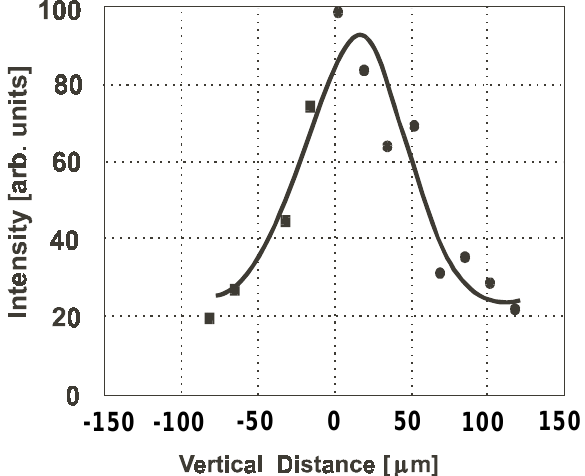
FIG. 8. Cross correlation of the electron and laser spot sizes when the Thomson scattering signal was measured during trans- verse scanning of the electron